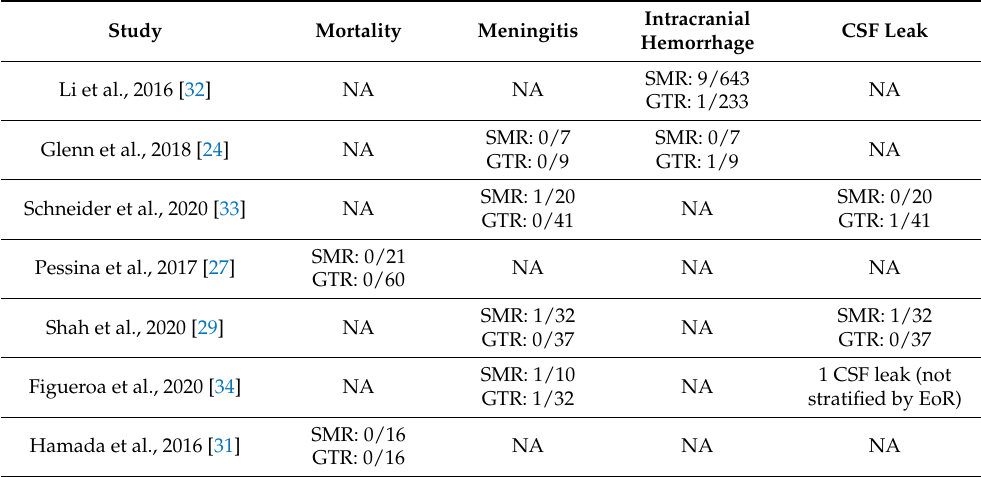
Table 3. Perioperative complications in studies comparing supramarginal resection with gross total resection of